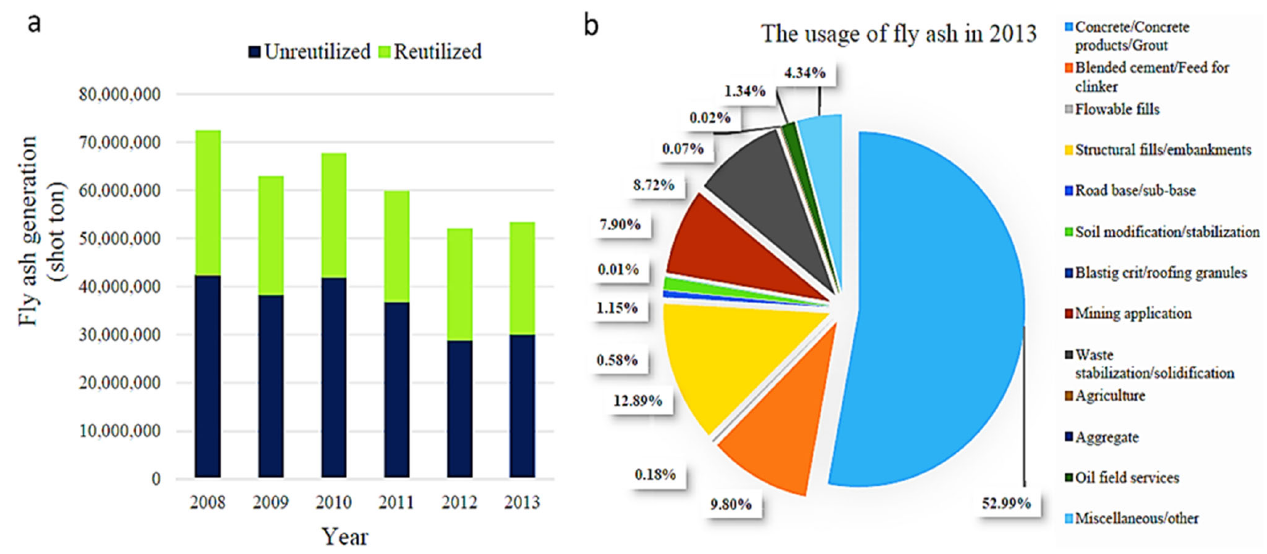
Figure 6. ( a ) FA generation in the United States from 2008 to 2019; ( b ) FA application fields in the United States in 2019. Adapted from [53].